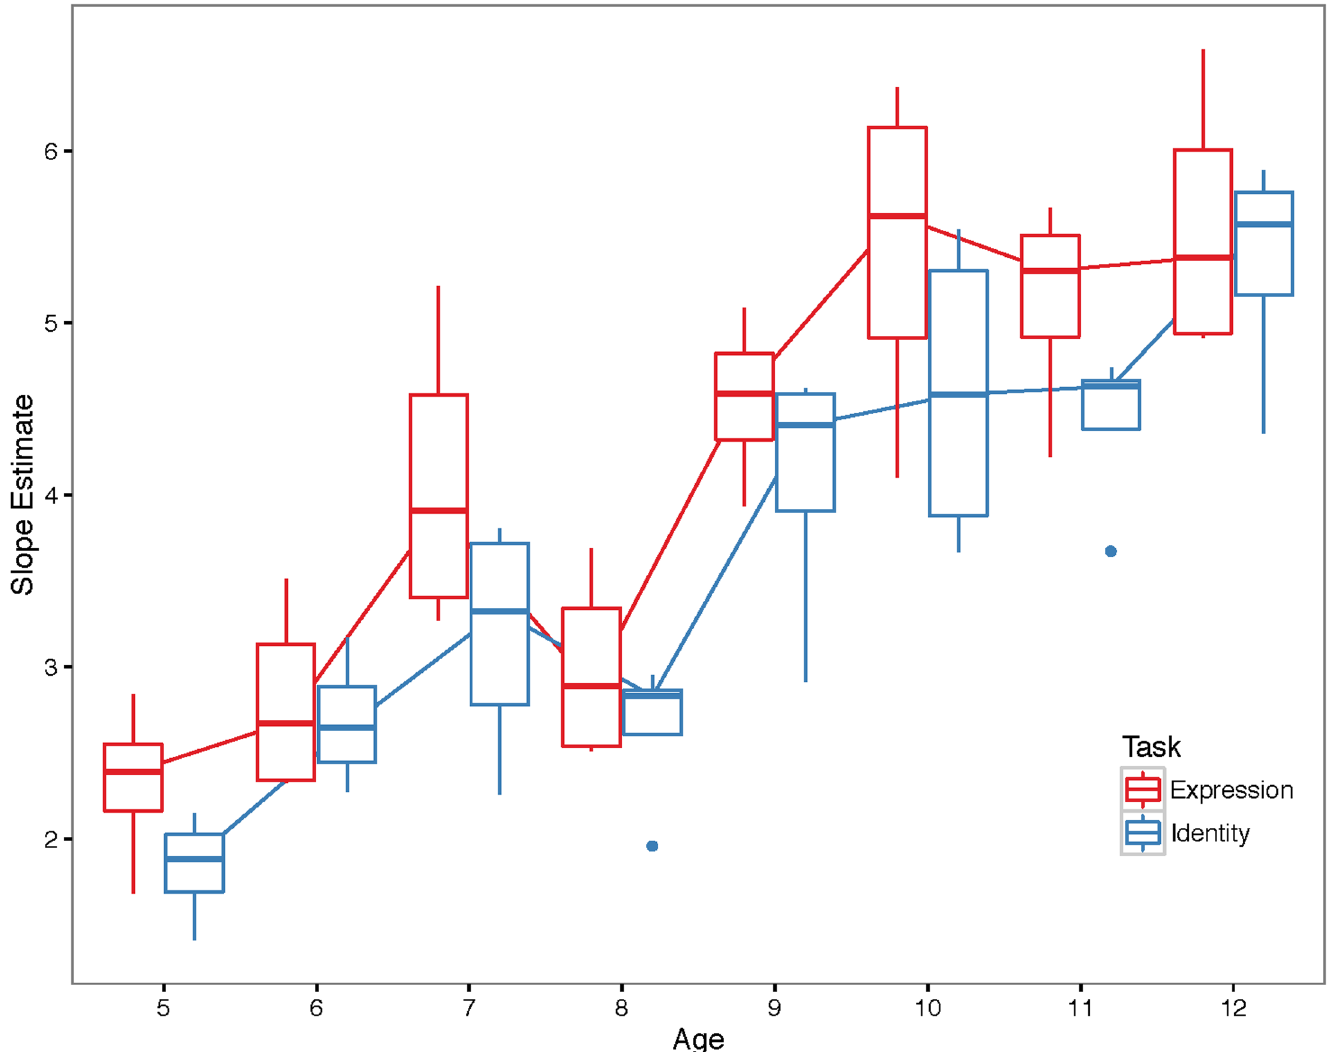
Fig 7. Slope estimates. Boxplots of the slope estimates for each age group and task. Individual points represent outliers (definedas those points exceeding1.5 times the inter-quartile range).